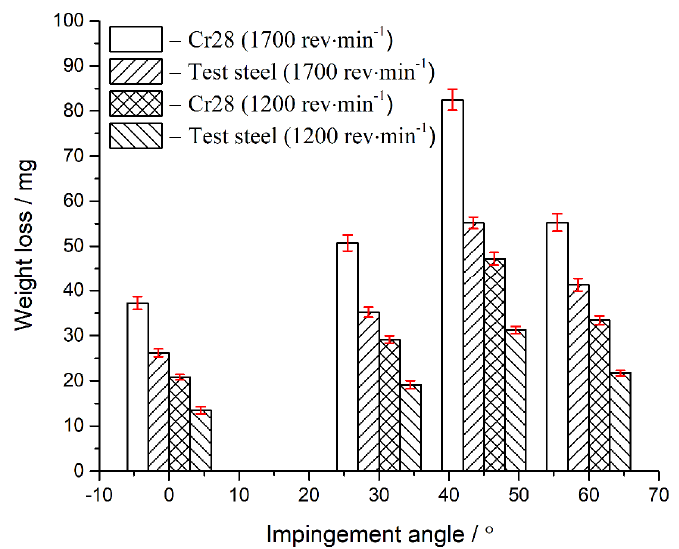
Figure 6. The erosion–corrosion weight loss analysis of the Cr28 white cast iron and boron-bearing stainless steel.